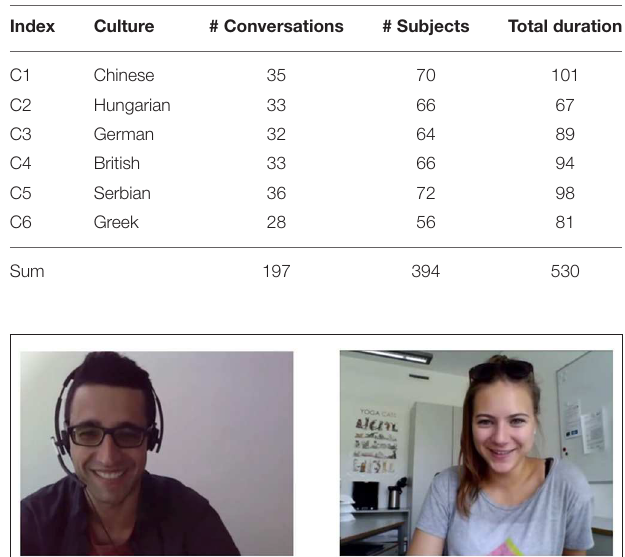
TABLE 1 | SEWA corpus: Quantity of conversations and subjects, as well as total duration given in minutes for each culture.